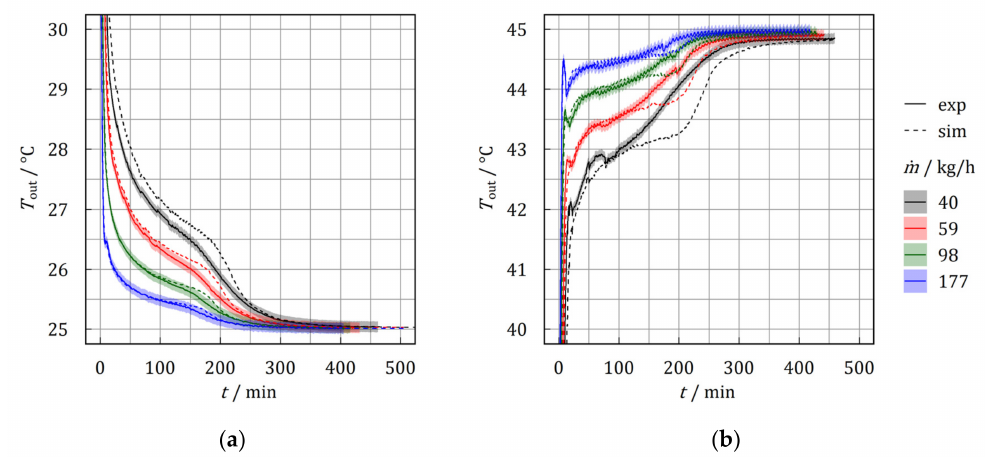
Figure 13. Outlet temperature of the storage of experiment (exp) and simulation (sim) for different mass flow rates for crystallization ( a ) and melting ( b ). The shaded area around the experimental data shows the uncertainty of the temperature sensor.